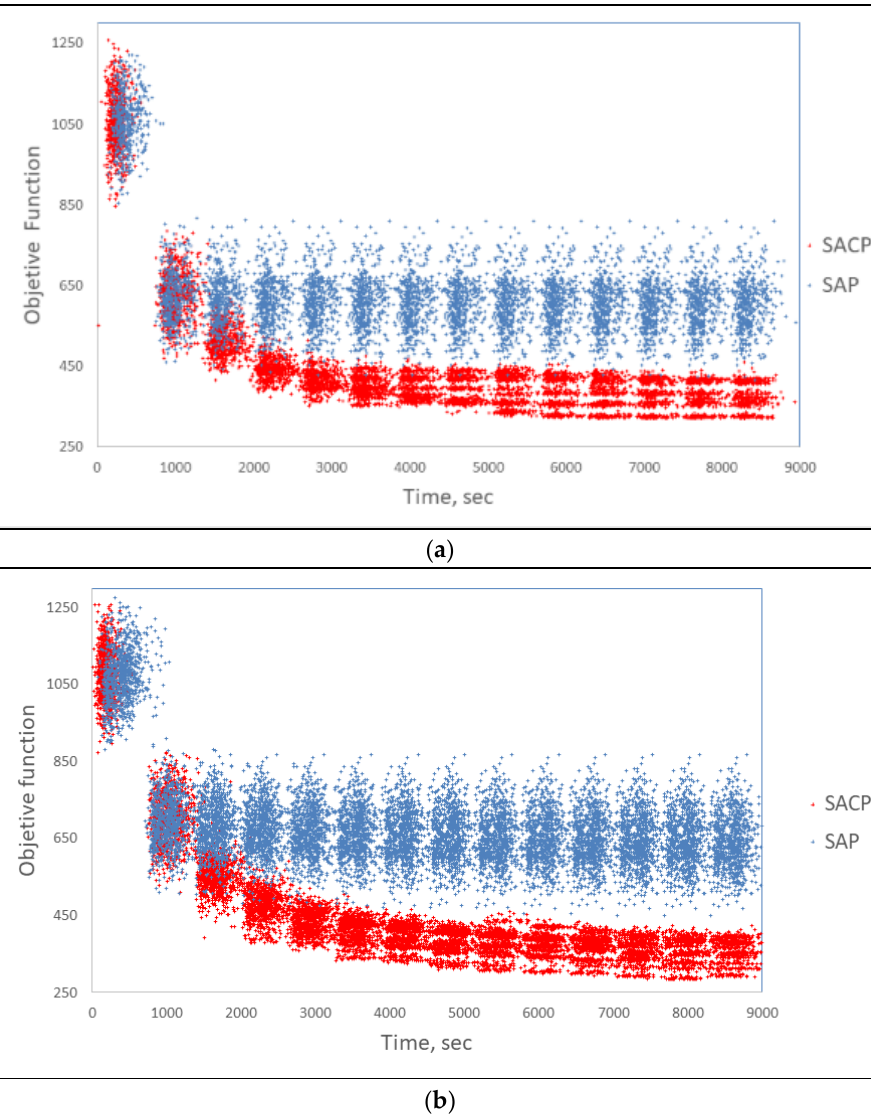
Figure 7. Processes with cooperation SACP and without cooperation SAP, in function of time with 48 processes. Results of 30 tests. ( a ) Instance large01. ( b ) Instance large02.